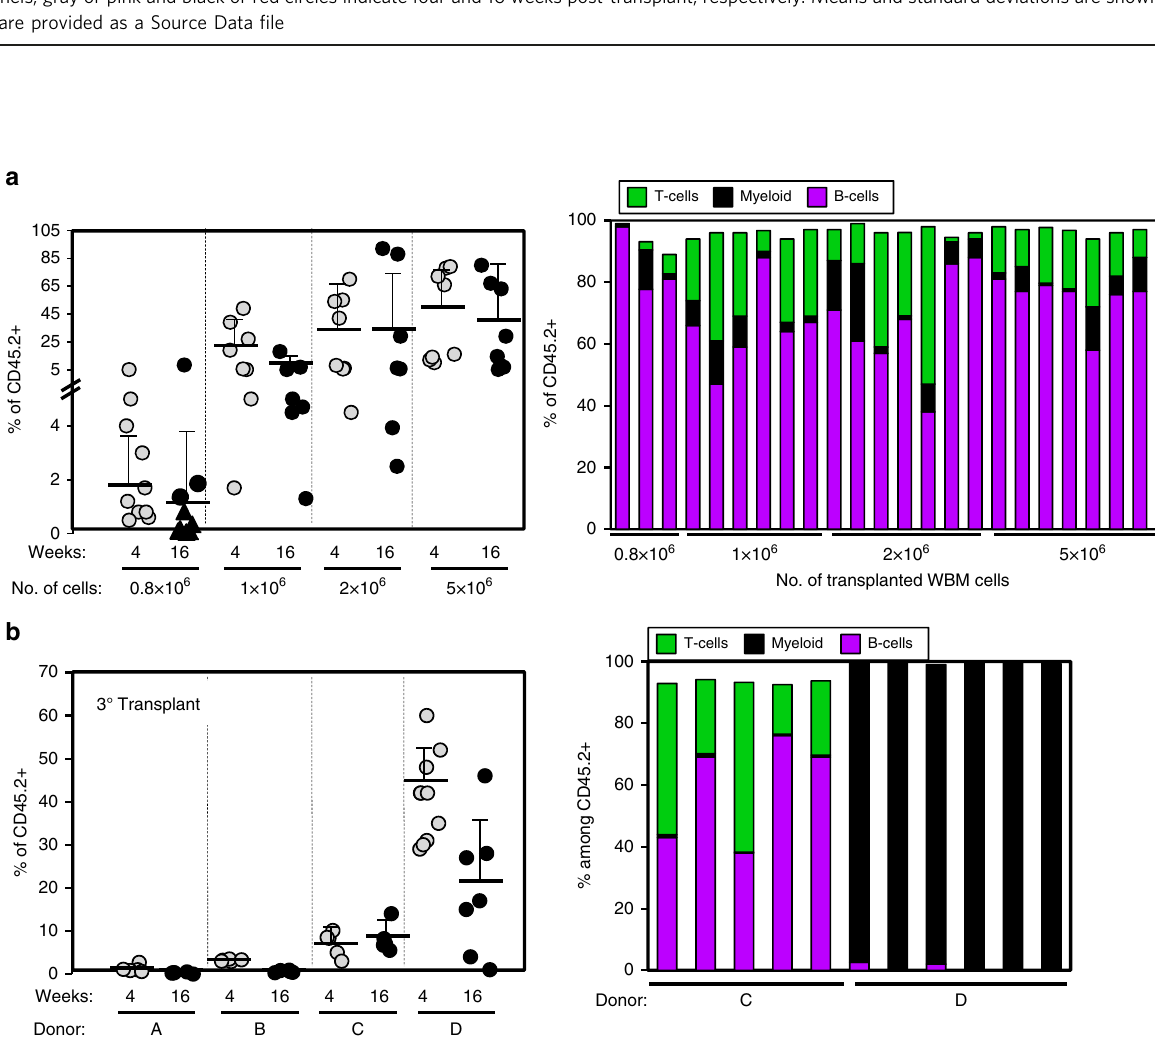
Fig. 1 Pre-circulation embryos but not YS yield robust dHSC activity. a Experimental schematic. Em and YS were dissected from E8-E8.5 (2 – 7sp) concepti and cultured as explants at the air-liquid interface for 9 – 10 days. Explants were then harvested, dissociated and transplanted at ≥ four embryo equivalent (e. e.)/recipient. b Left panel: CD45.2 + (i.e., 2 – 3sp Em-Ex ( n = 7), 5 – 7sp Em-Ex ( n = 11), 2 – 3sp YS-Ex ( n = 5) or 5 – 7sp YS-Ex ( n = 11)) contribution to PB of primary recipients. Data pooled from 16 independent experiments. Generally, tissues from one independent litter were transplanted per experiment. For 2 – 3sp explants, all YS-Ex ( n = 5) were transplanted in parallel with Em-Ex isolated from the same concepti. For 5 – 7sp explants, all YS-Ex ( n = 11) were transplanted in parallel with at least one Em-Ex isolated from the same concepti as a positive control for engraftment (** p < 0.01, eWrs-test). Right panel: Frequency of myeloid cells, T cells and B cells in CD45.2 + PB and representative fl ow cytometry plots of primary recipients of 2 – 3sp and 5 – 7sp Em-Ex 16 weeks post-transplant. Each column represents an independent recipient. For the 5 – 7sp Em-Ex, only the engrafted mice are shown ( n = 9). c CD45.2 + YS were isolated from E8.5 (5 – 7sp, n = 8 recipients), E9.5 (19 – 22sp, n = 3 recipients), E10.5 (32 – 36sp, n = 3 recipients) or E11.5 (46 – 47sp, n = 7 recipients) concepti, cultured as explants for fi ve or seven days and then transplanted at eight ee/recipient. Data pooled from fi ve independent experiments. (* p < 0.05, eWrs-test). d YS-Ex and Em-Ex were isolated from CD45.2 + E9.5 (19 – 22sp) concepti and cultured under the same conditions